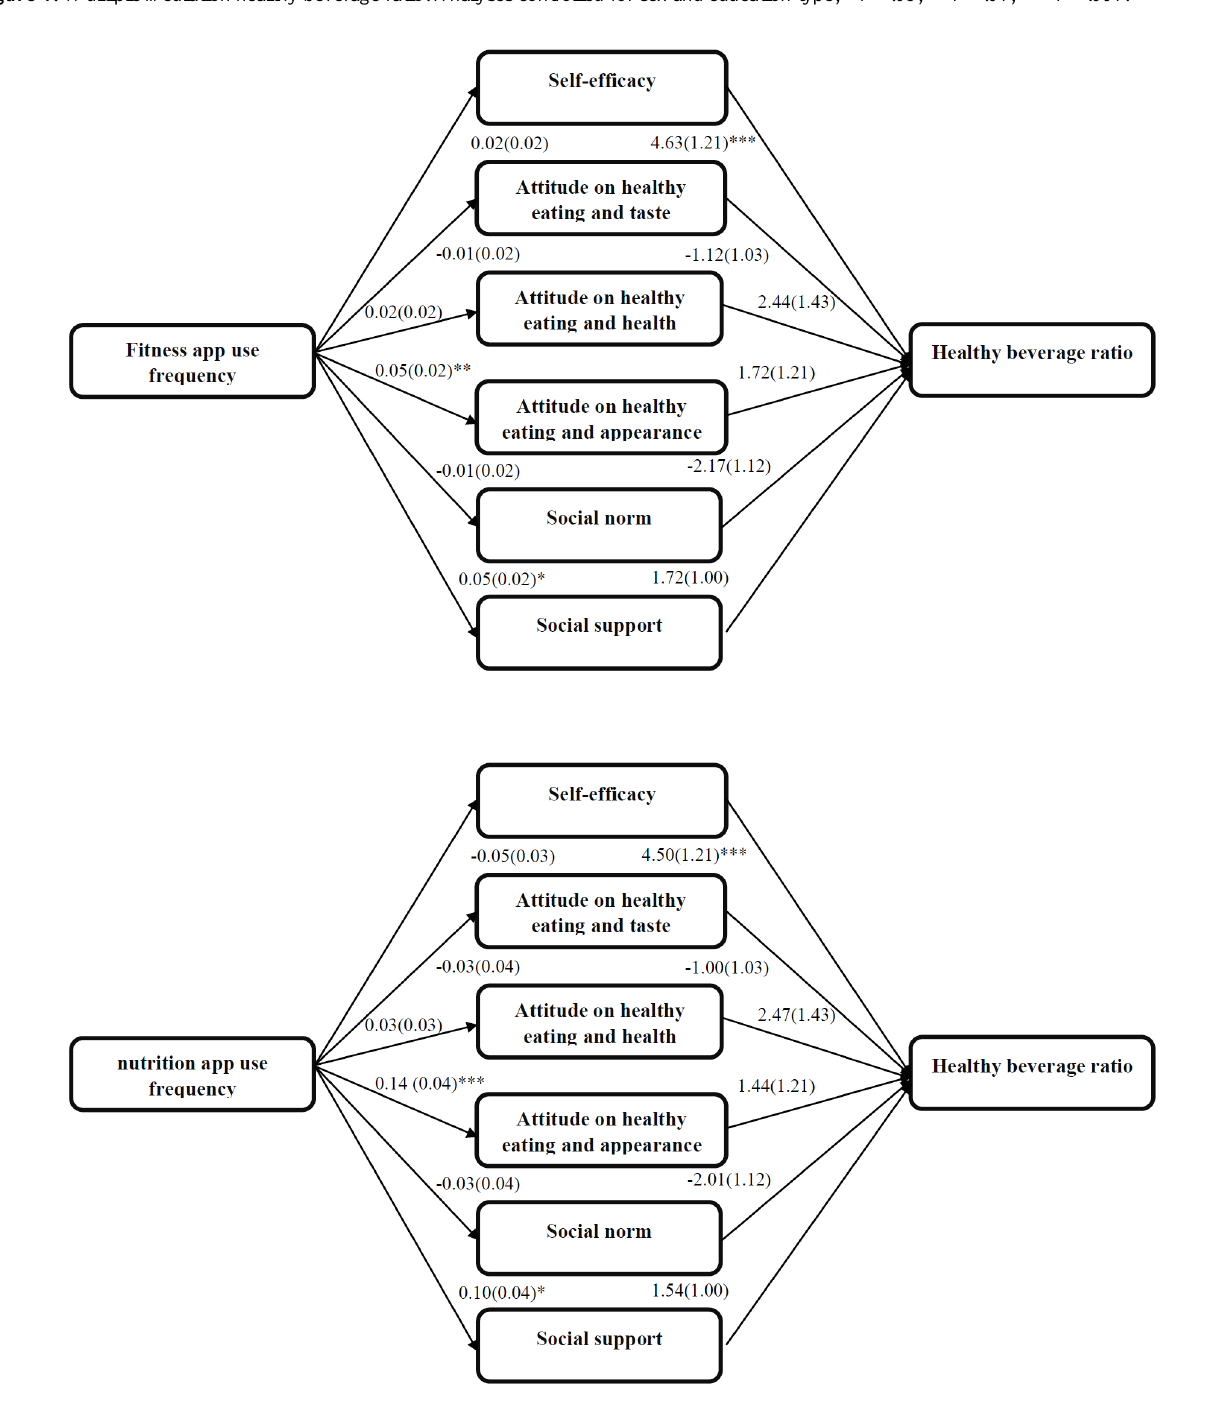
Figure 4. Multiple mediation healthy beverage ratio. Analyses controlled for sex and education type; * P <.05, ** P <.01, *** P